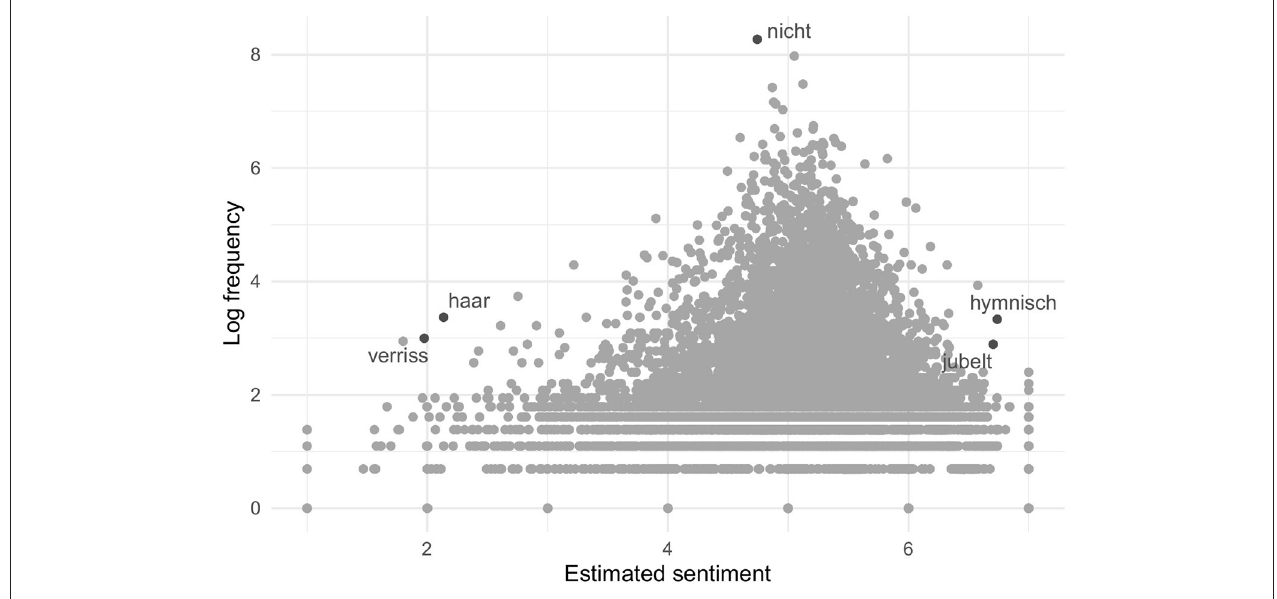
FIGURE 2 | Sentiment of words estimated by supervised